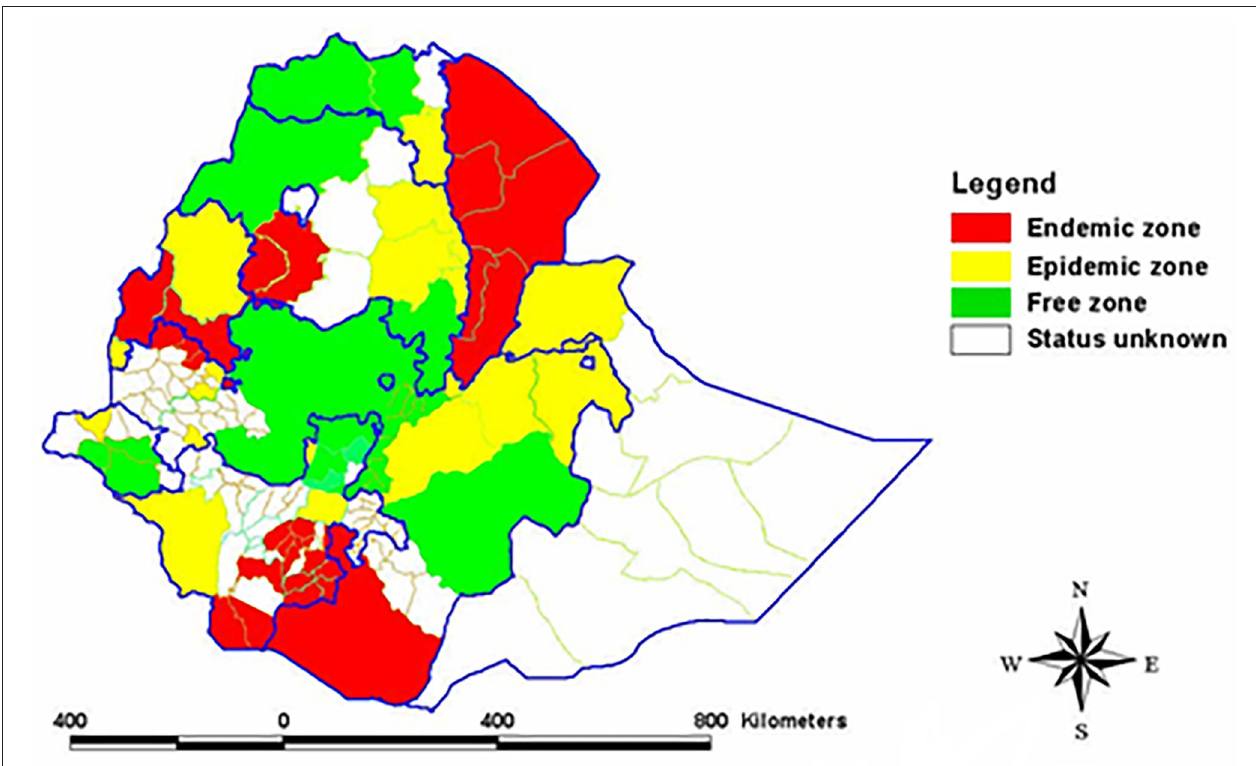
FIGURE 2 | Map showing the different CBPP zones of Ethiopia. Source: